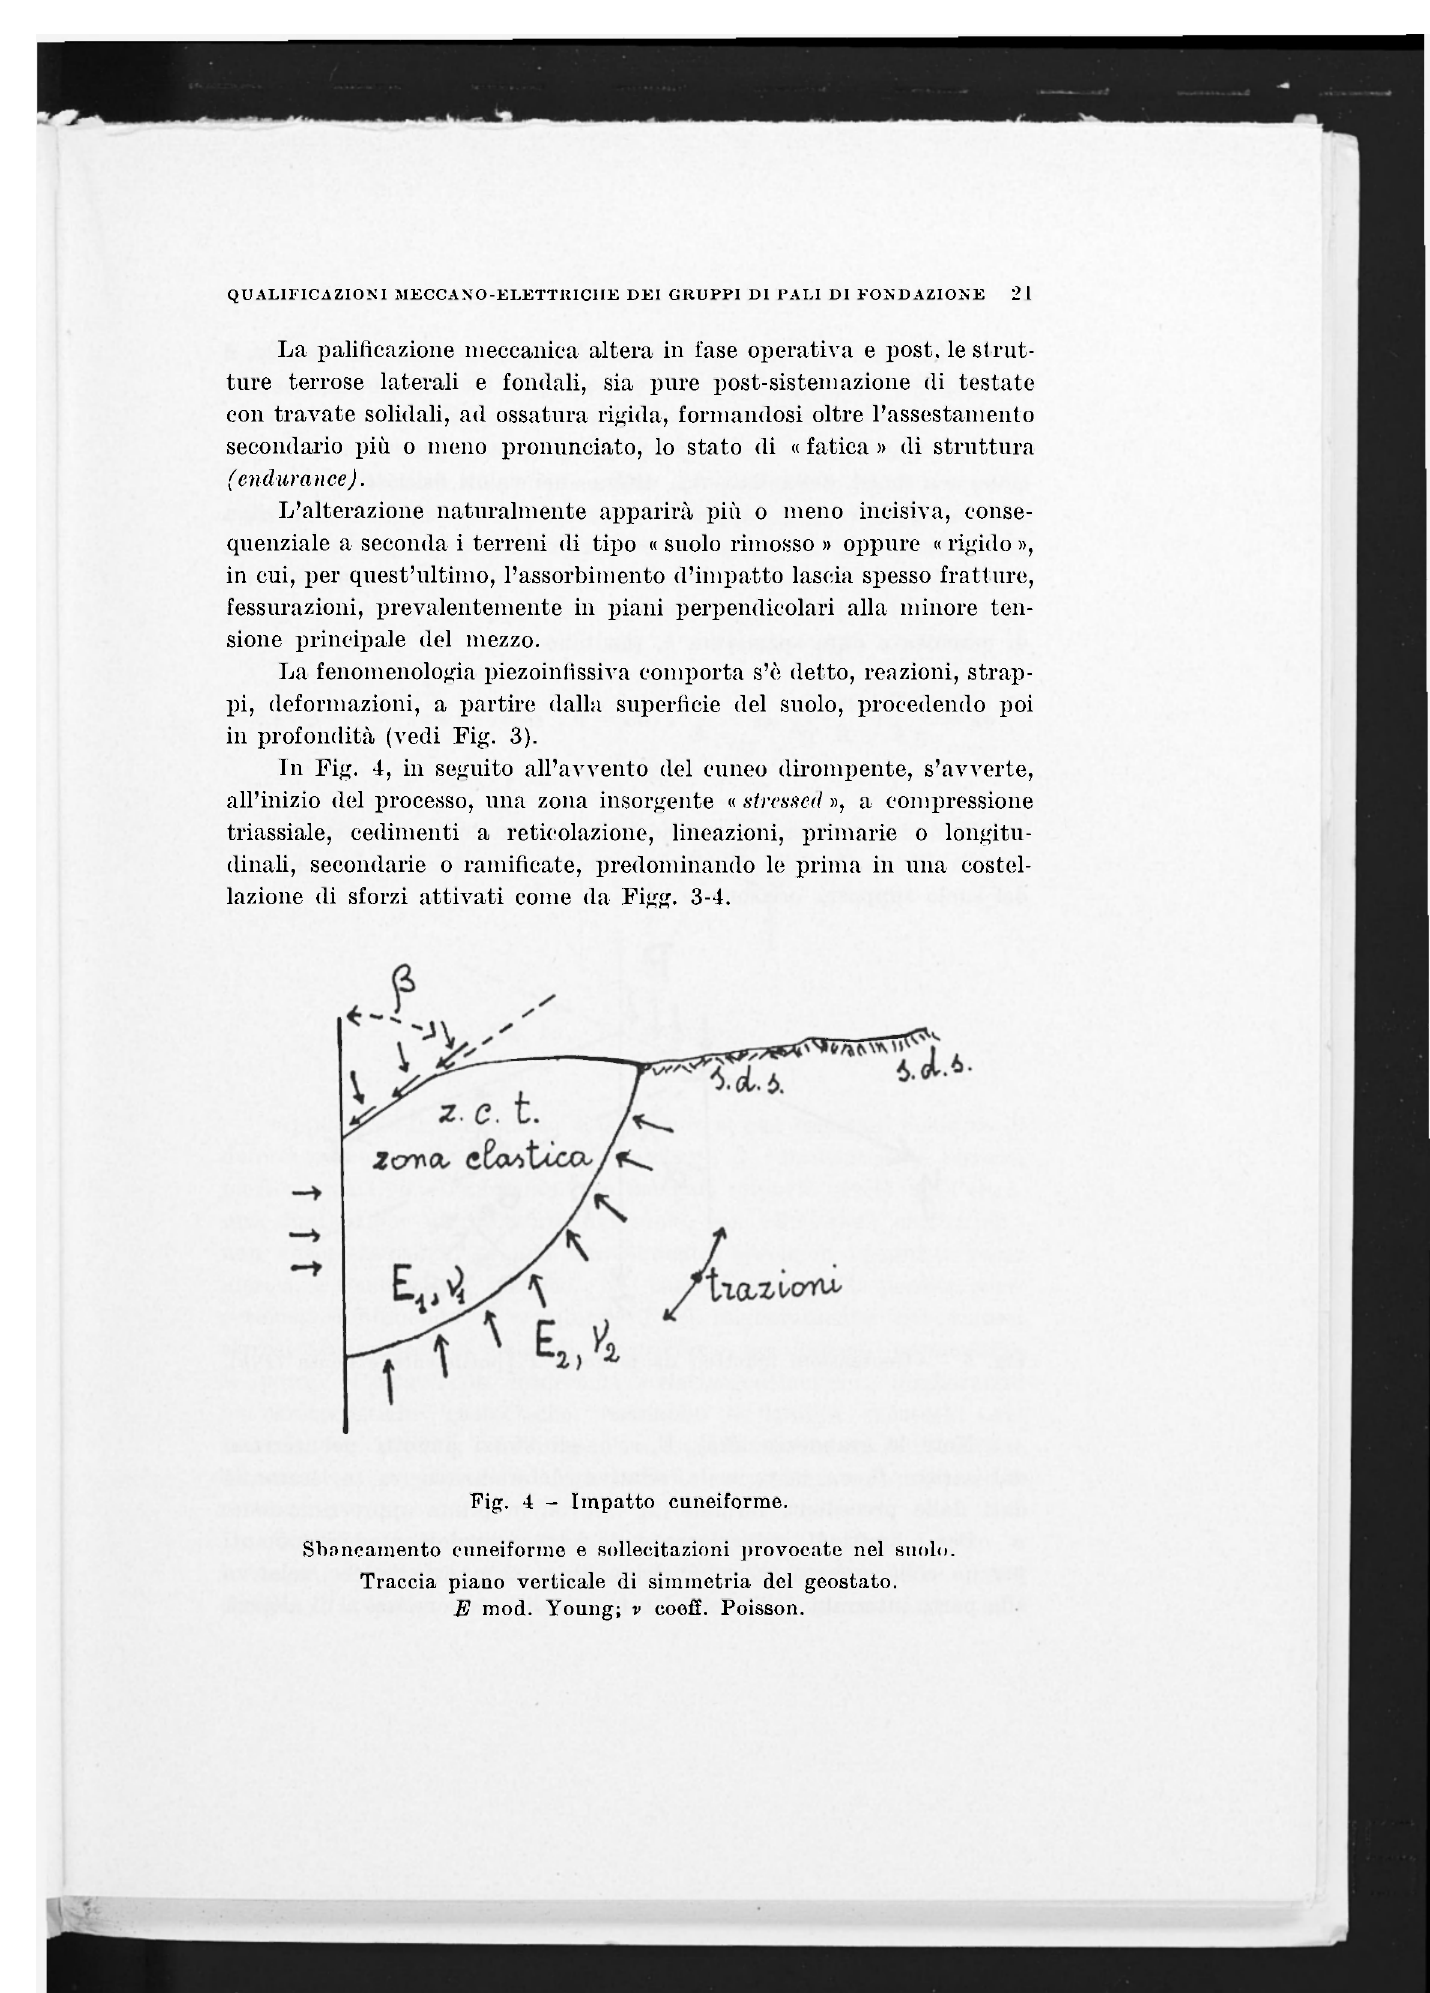
Fig. 4 - Impatto cuneiforme. Sbancamento cuneiforme e sollecitazioni provocate nel